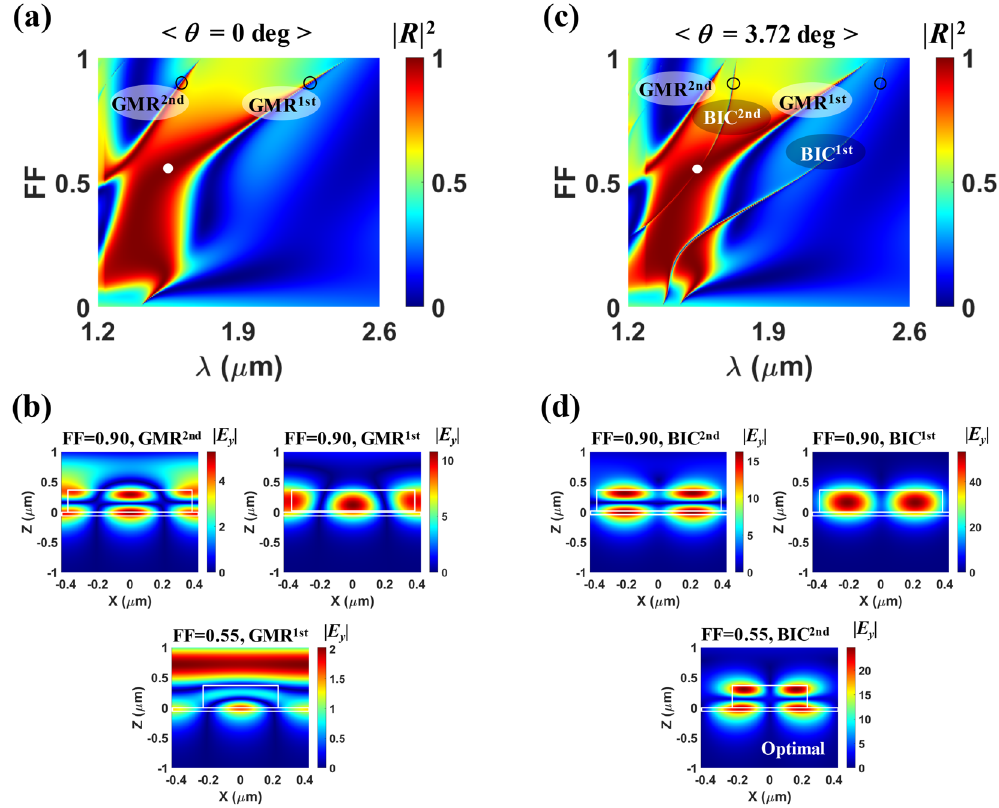
Figure 3. Reflectance spectra as a function of FF at ( a ) θ = 0 (normal incidence) and ( c ) θ = 3.72 deg (oblique incidence) for the proposed structure without graphene, where Period = 0.85 µ m, d Grat = 0.367 µ m, and d Slab = 0.052 µ m. ( b ) and ( d ) indicate the normalized electric field distributions (| E y |) at different conditions marked by open and solid circles in ( a ) and ( c ) respectively are plotted: FF = 0.90 (upper panel), FF = 0.55 (lower